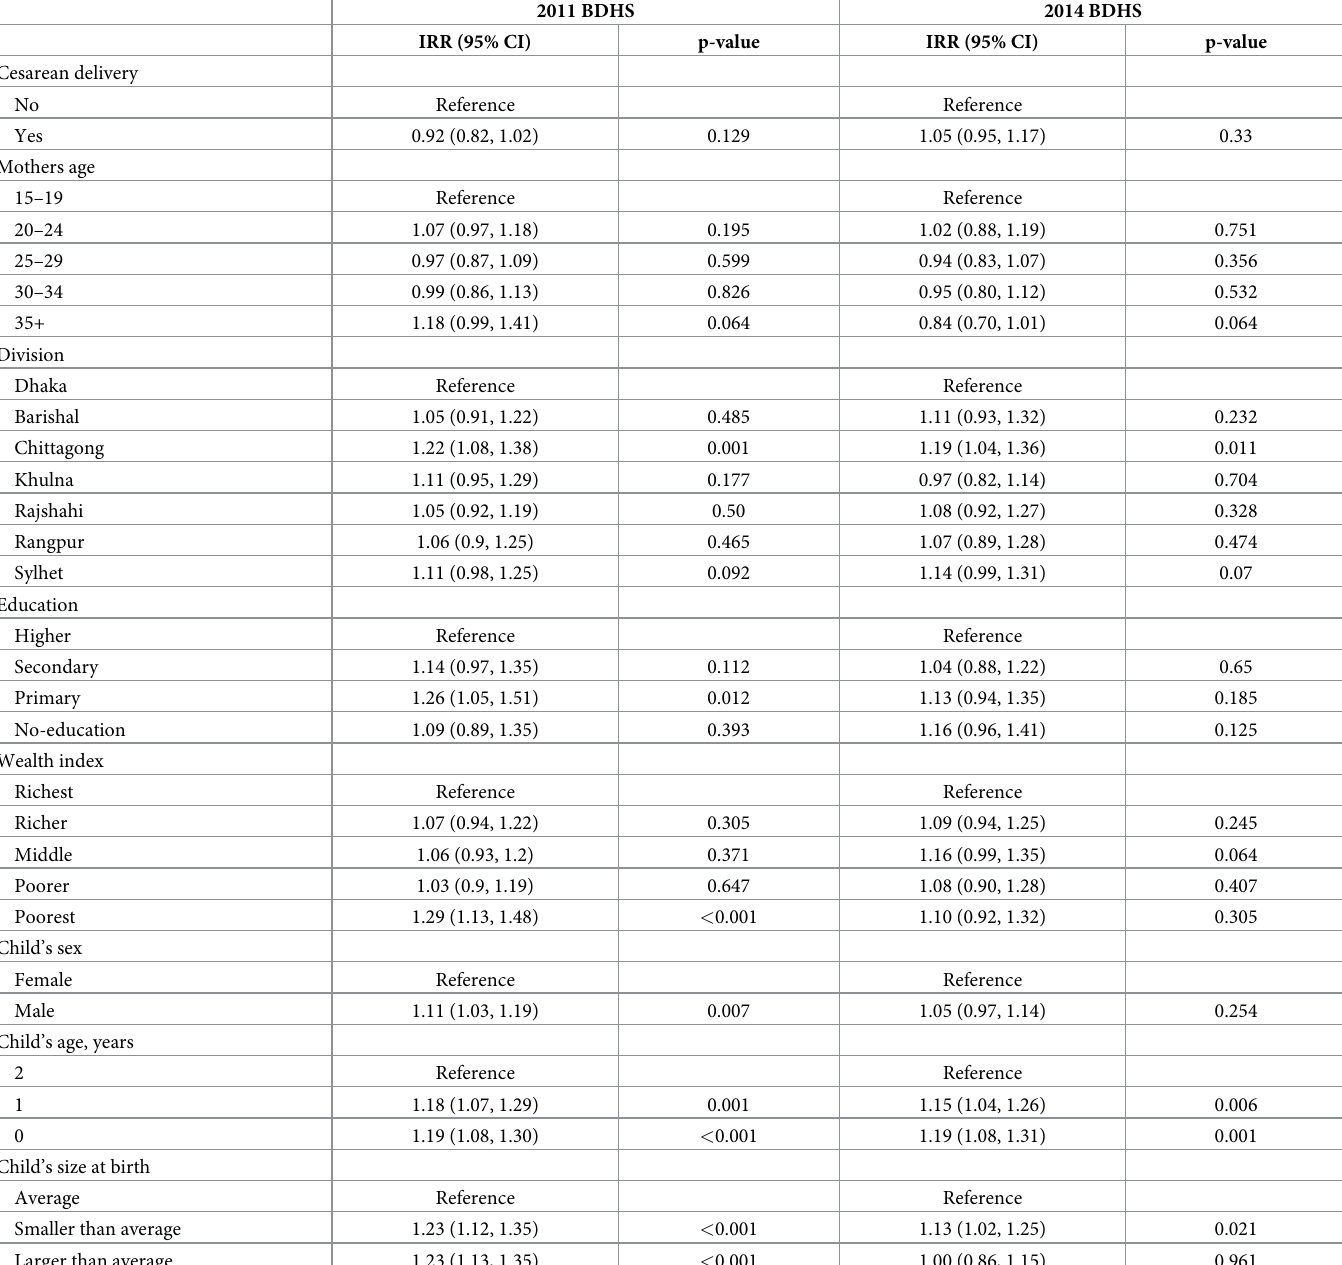
Table 3. Factors associated with cesarean vs normal delivery and common childhood diseases, BDHS 2011and